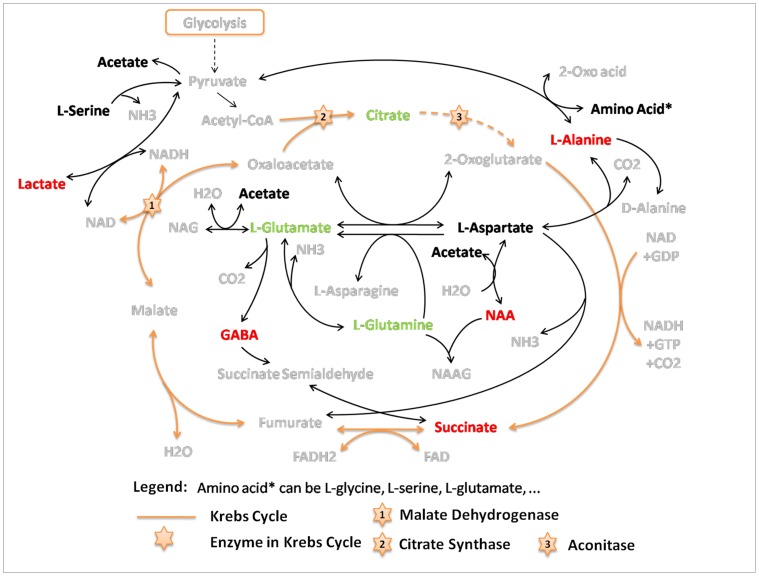
Top altered pathways in rat cortex and hippocampus induced by subchronic MK-801 treatment.Metabolite variation information here refers to the trends of changes (not only statistically significant changes). Metabolites in red (green) increased (decreased) in two brain areas; metabolites in black changed in opposite directions in two brain regions. Solid-lined arrows indicate direct biochemical reactions, while dashed-lined arrows represent a skip of intermediate reactions.